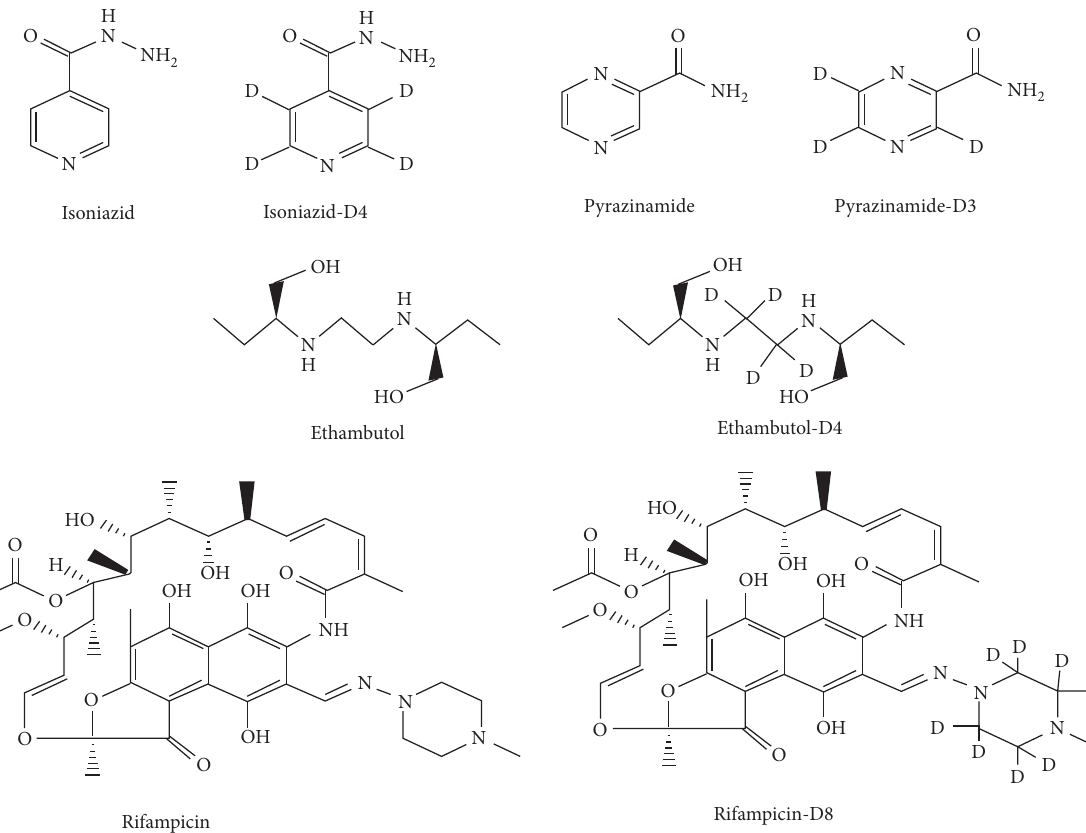
Figure 1: Molecule structures of the four analytes and Table 1: Optimized compound-dependent MS parameters for detection of the analytes and ISs. Compound